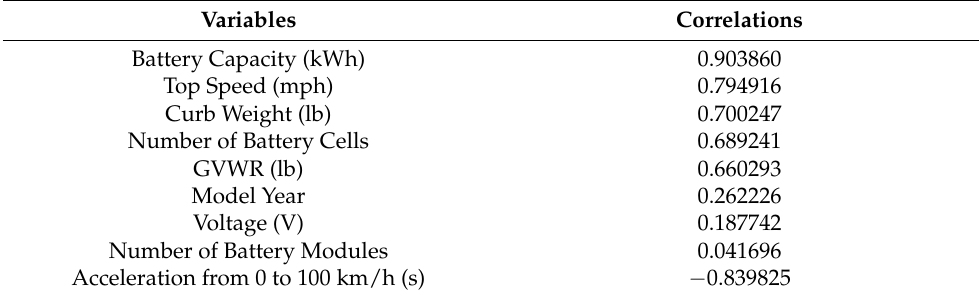
Figure 5. Scatter plot of independent variables, ( A ) EV model year, ( B ) battery capacity (in KWh), ( C ) top speed, ( D ) acceleration from 0 to 100 km/h (in s), and ( E ) EV curb weight (in kg), with EPA range, with scatter points colored differently based on EV body style. Table 1. Correlations between independent variables and